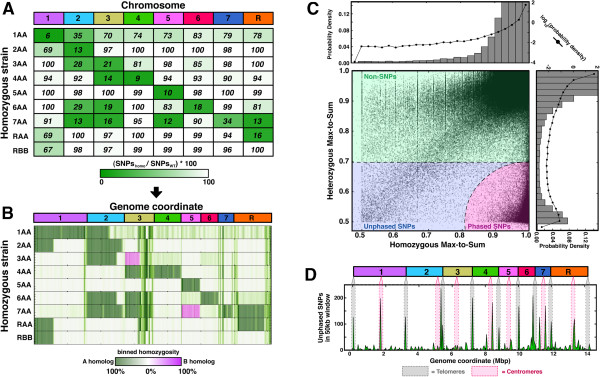
Pooling reads across heterozygous and homozygous regions clearly identified SNPs. (A) For each homozygous strain independently, the number of positions with max-to-sum ratio <0.7 were considered ‘putative SNPs’; the total number of putative SNPs on each chromosome was called SNPshomo, and this number was divided by the corresponding value for wild type; to avoid confusion, the plotted number is the minimum of this quotient and 100%. (B) Putative SNP locations were identified in the wild-type strain, and the corresponding positions in homozygous strains were investigated for SNP status: if a putative SNP position from wild type was not a SNP in the indicated strain, it was shaded green (or pink, depending on the allele), whereas if both were SNPs, the latter was shaded white. (C) Scatterplot of max-to-sum ratios in heterozygous and homozygous regions for every position in the genome. Histograms at top and right show the distribution of data on each perpendicular axis as indicated, with bars in linear space and lines in log space. (D) The number of unphased SNPs in non-overlapping 50 kb windows tiled across the genome, with telomere and centromere locations as indicated.